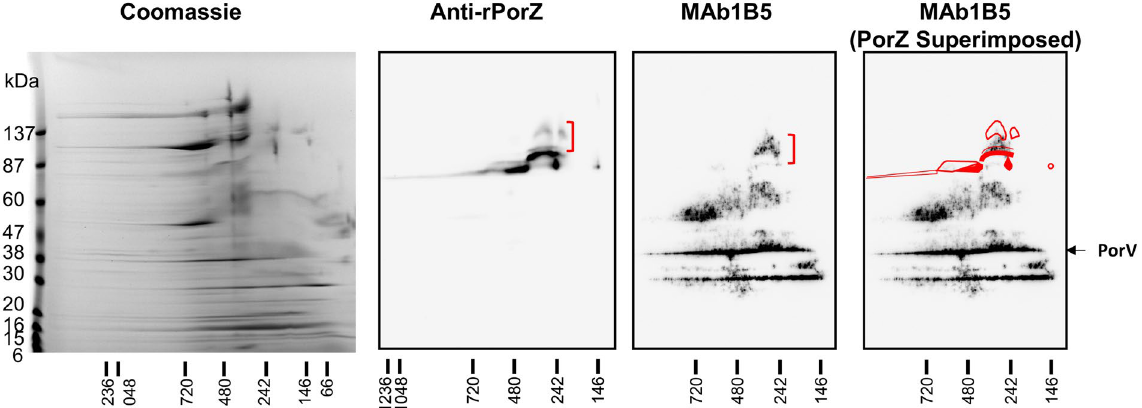
Figure 6. PorZ appears to bind A-LPS in the porU mutant. OMV lysate from the W50 porU mutant was subjected to 2D BN-PAGE and separately stained with Coomassie or sequential Western blots with anti-rPorZ then stripped and probed with anti-rPorV mouse antiserum followed by MAb1B5. The small population of PorZ co-aligning with MAb1B5 staining is indicated by red